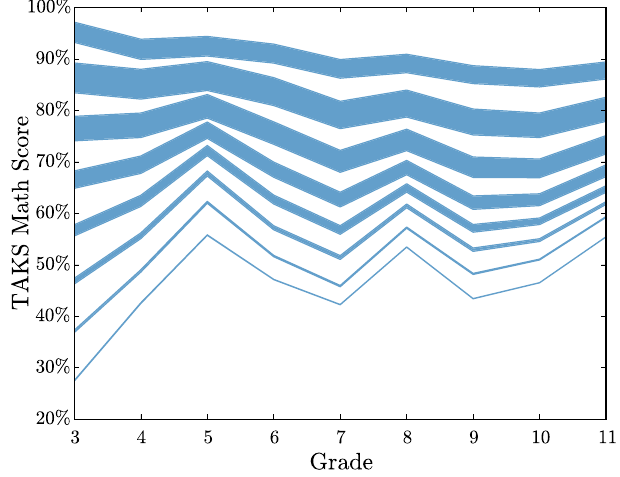
FIG. 2. Trajectories for the cohort of students who graduated in 2012. The students are sorted into percent score deciles by their maximum 3rd grade mathematics TAKS score in 2003. The average scores for these groups of students are then plotted for the subsequent grades in the following years, and these average scores are connected in linear segments. The thickness of the trajectory is proportional to the number of students in that group. There are approximately 271 500 students included in this